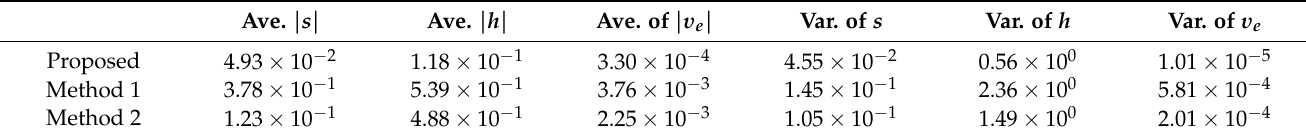
Table 5. The specific data of tracking errors under